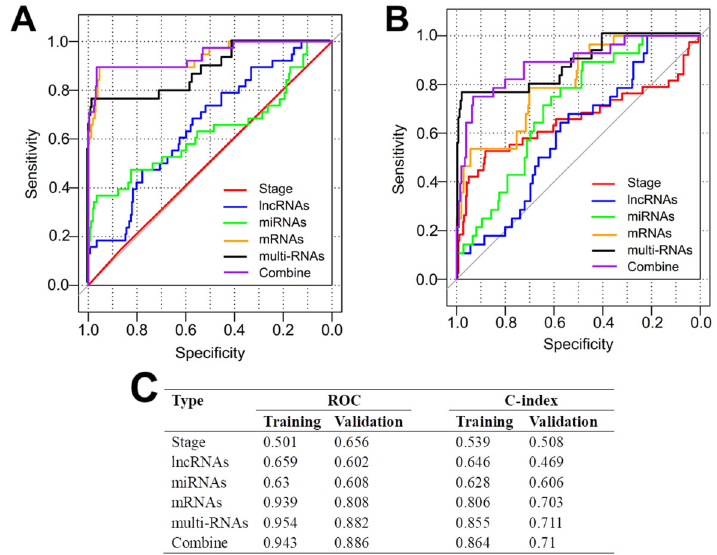
Figure 6. Comparison of the prognostic power among the risk score model, the FIGO staging, and mRNA, miRNA, lncRNA alone. A , Time-dependent receiver operator characteristic curves (ROC) using the training dataset (GSE44001). B , Time-dependent ROC curves using the testing dataset (TCGA). C , Calculated results for ROC and